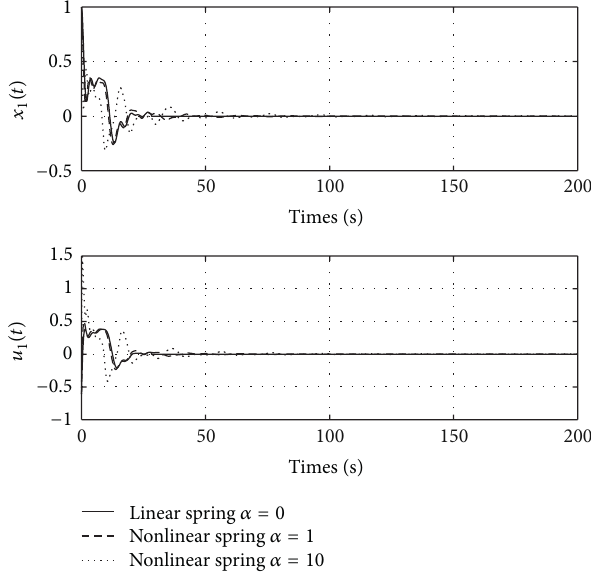
Figure 14: Effect of nonlinear spring stiffness on the displacement response and the control input for mass